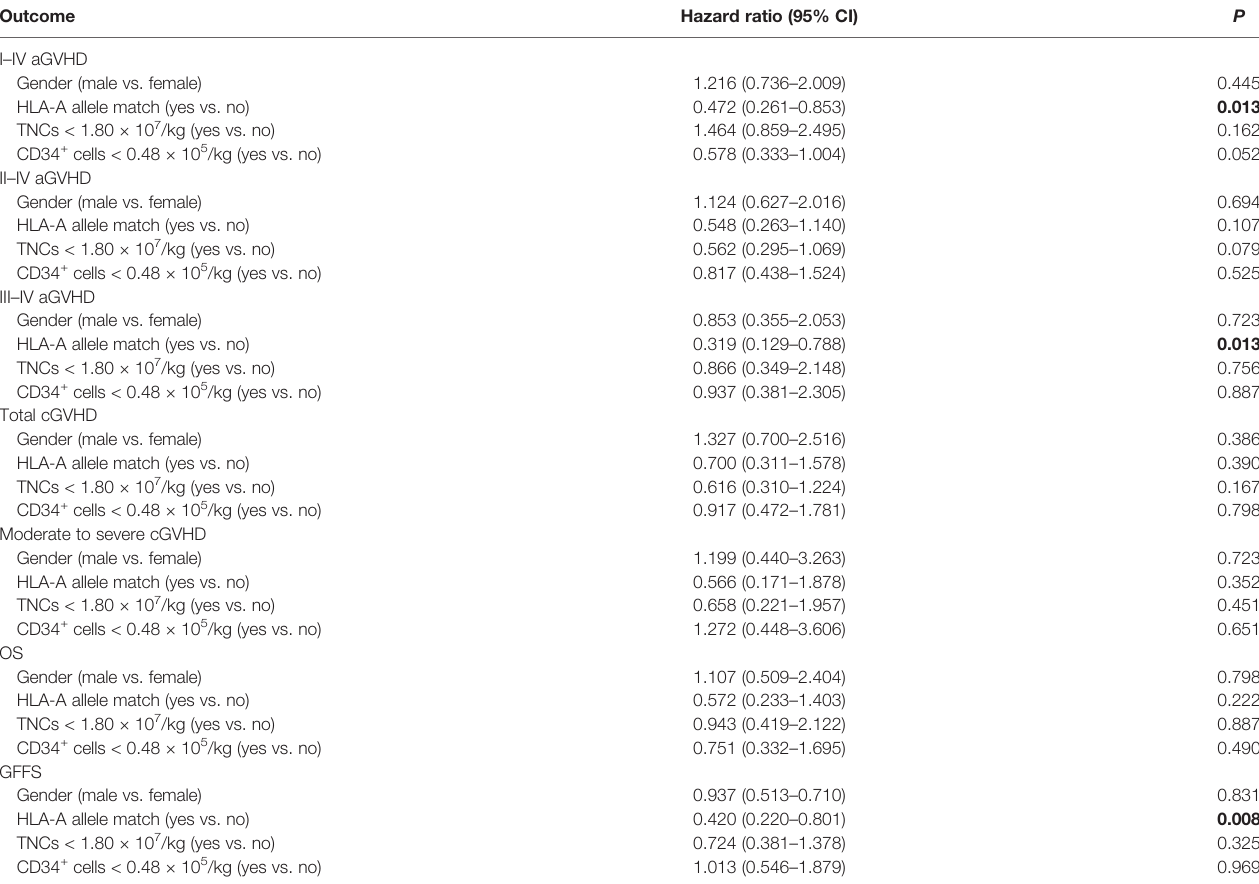
CI,con fi denceinterva;vs,versus;Haplo-cordHSCT,haploidenticalhematopoieticstemcelltransplantationwithunrelatedcordbloodinfusion;HLA,humanleukocyteantigen;TNCs,total nucleated cells; ANC, absolute neutrophil count; aGVHD, acute graft-versus-host-disease; cGVHD, chronic GVHD. OS, overall syrvival; GFFS, GVHD-free/failure-free survival. Bold values means P with statistical signi fi